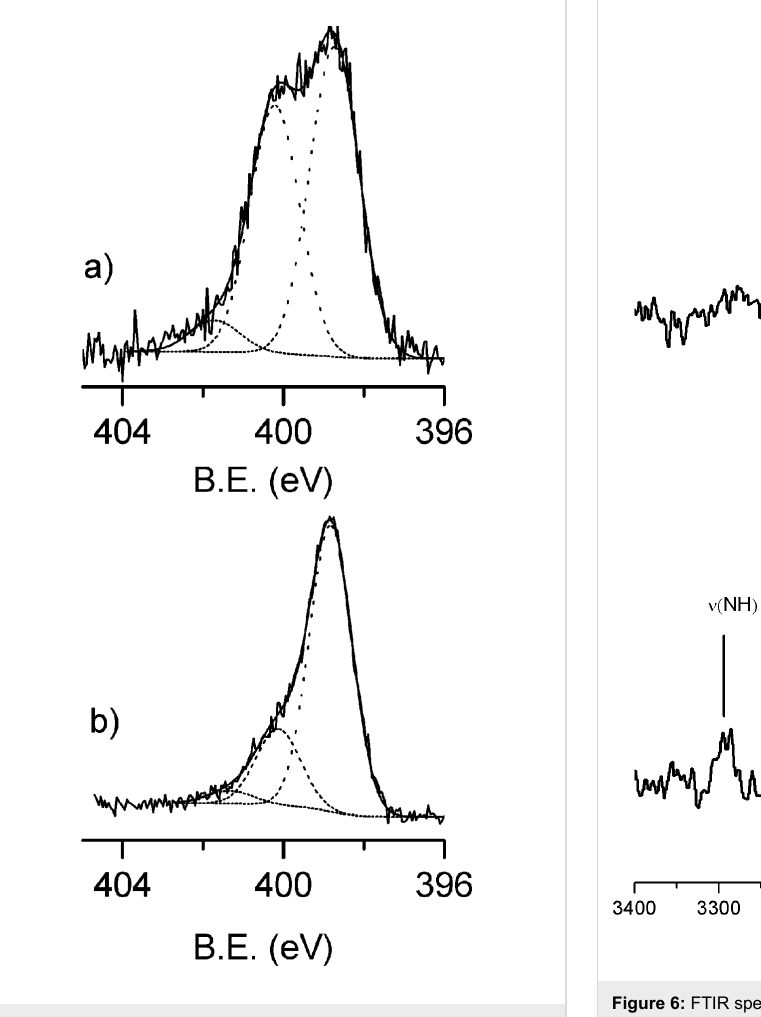
Figure 5: N 1s XPS region of Si-Co-Pc (a) and PSi-Co-Pc (b).